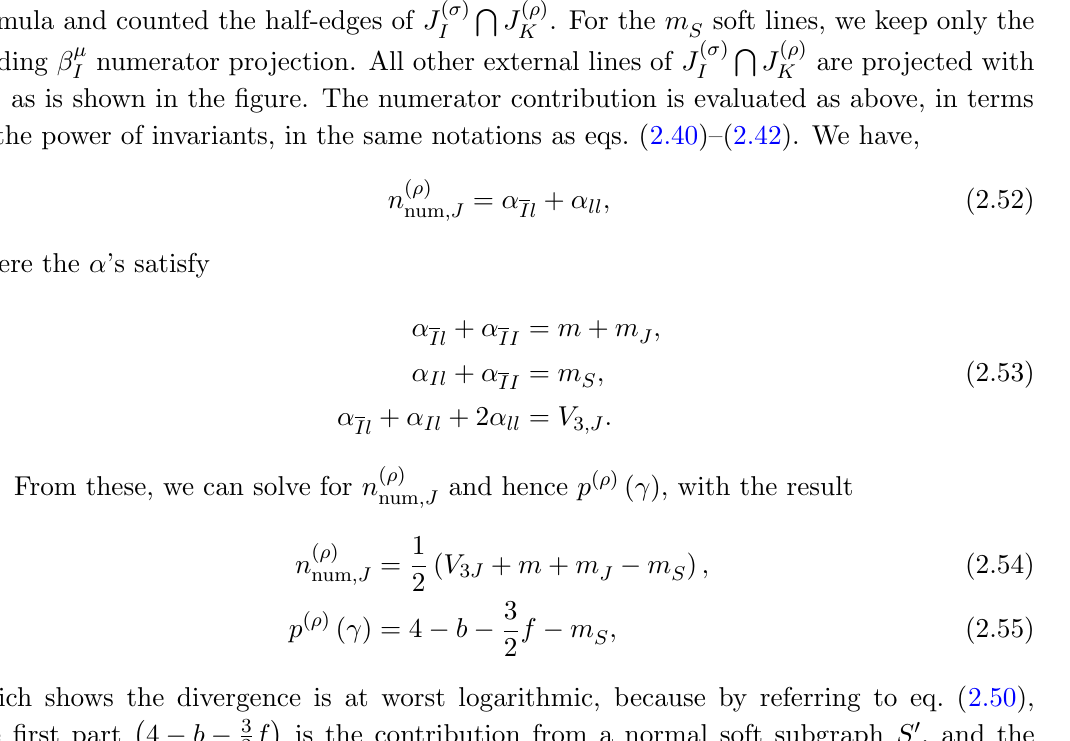
Figure 17. The subgraph (cid:13) (cid:16) (cid:17) S S ( (cid:27) ) T J ( (cid:26) ) S 0 that is marked green in ( b ). Both subgraphs are depicted in (cid:26) . The I